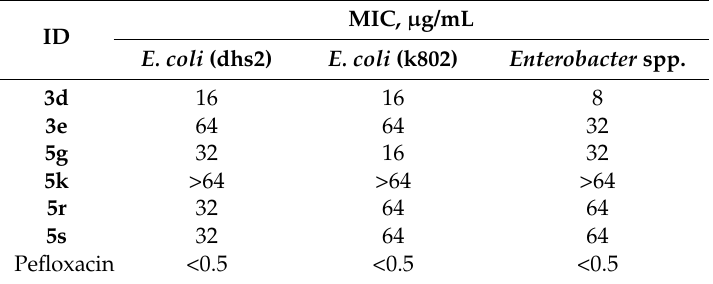
Table 2. Antibacterial activity of compounds 3d , 3e , 5g , 5k , 5r , and 5s .